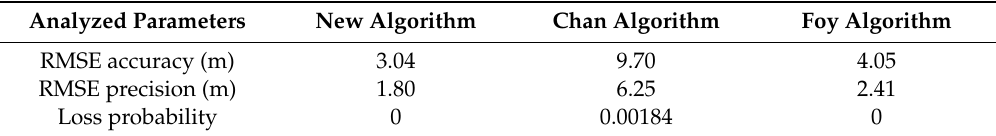
Table 4. Results of comparative analysis when PIMs were placed on the first floor of un-inhabited single-family house and RNs were deployed outside